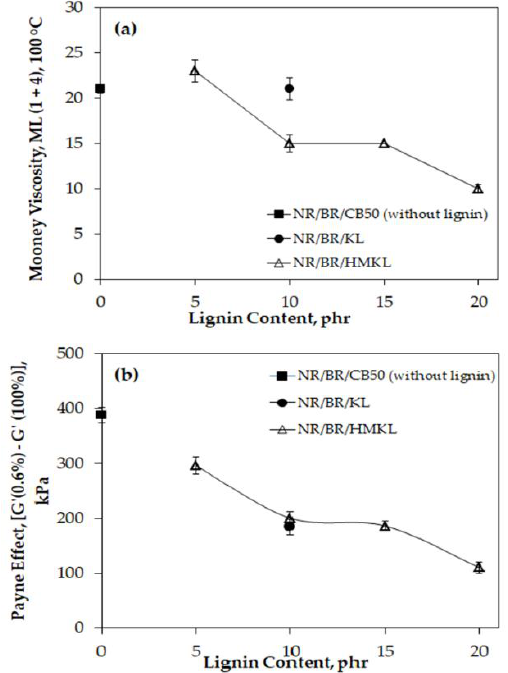
Figure 5. The e ff ect of HMKL content on ( a ) the Mooney viscosity and ( b ) the Payne e ff ect of lignin-filled Figure 5. The effect of HMKL content on ( a ) the Mooney viscosity and ( b ) the Payne effect of lignin- natural rubber / polybutadiene rubber (NR / BR) compounds. filled natural rubber/polybutadiene rubber (NR/BR) compounds.